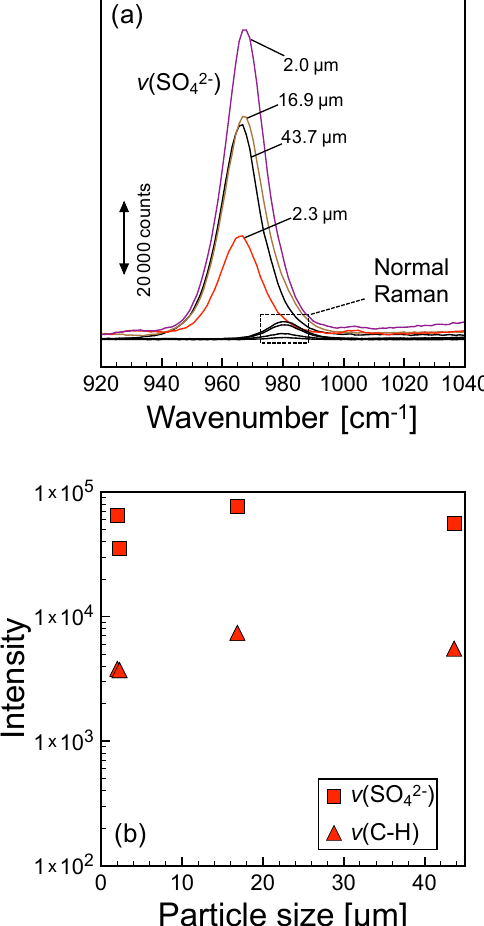
Figure 8. (a) Enhanced Raman spectra of the AS / sucrose parti- cles as a function of particle size in the lower energy region (920– 1040cm − 1 ). The peak band is assigned to the v (SO 2 − normal Raman spectra are also shown for comparison. (b) Raman intensity as a function of particle size for the v (SO 2 −